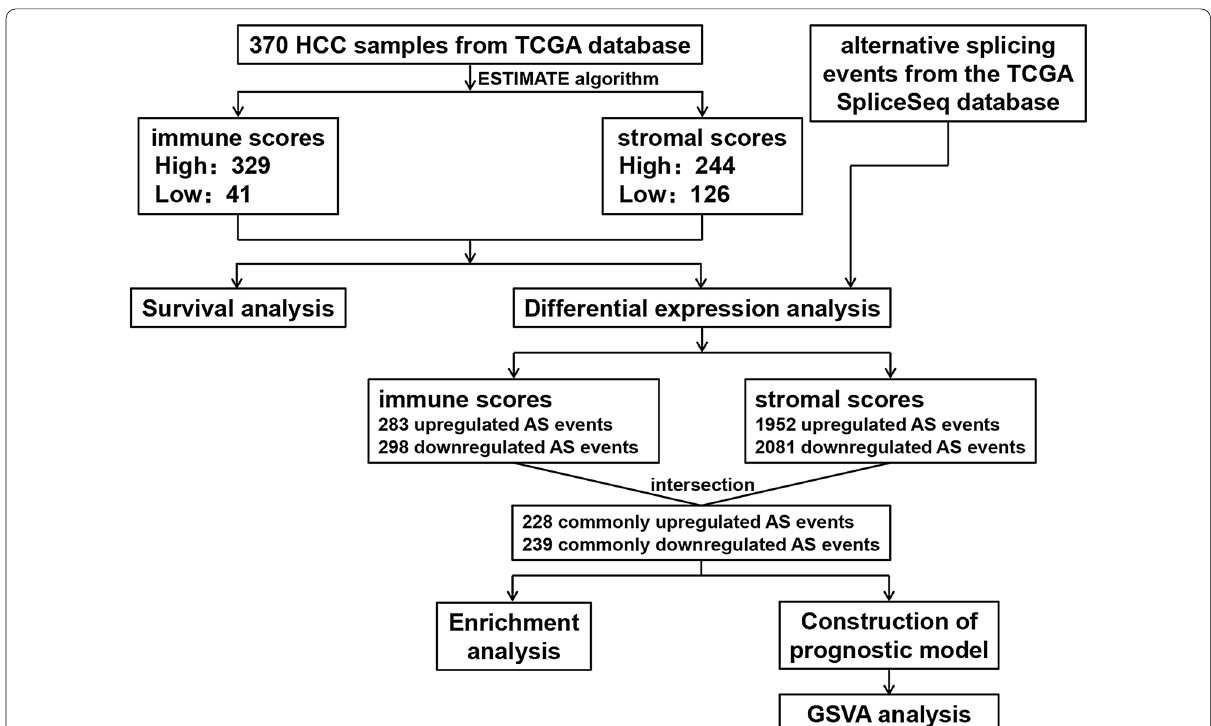
Fig. 1 The workflow of the study. HCC hepatocellular carcinoma, TCGA The Cancer Genome Atlas database, AS alternative